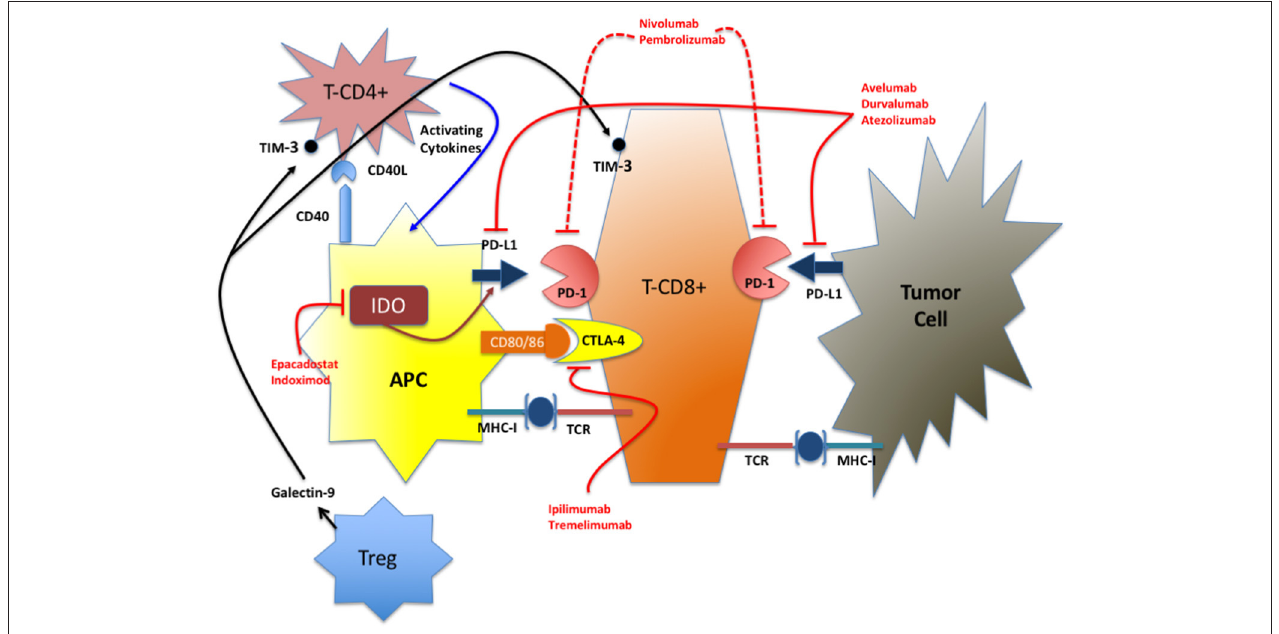
FIGURE 1 | Simplified representation of the IC network. In red are indicated the FDA-approved drugs and the IDO inhibitors in advanced stage of clinical test (phase III). TIM-3 inhibitors are at an early stage of development for clinical use (phase I).